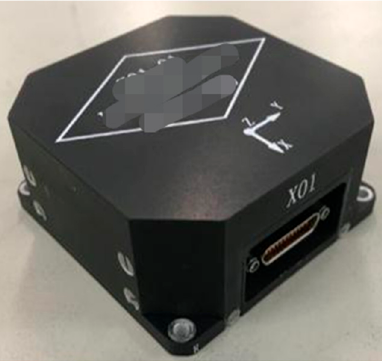
Figure 1. The navigation grade MEMS gyroscope unit product.